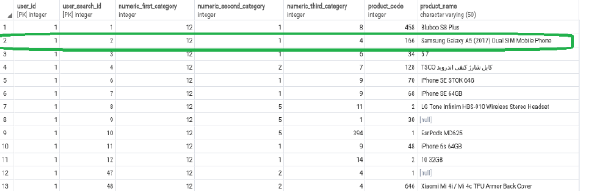
Figure2(a) An overview of the webpage link